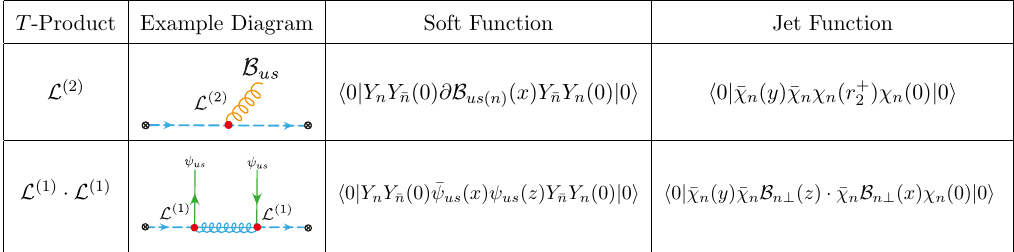
( (cid:21) 2 ) thrust cross section from radiative functions. O (2) insertions, in accord with the LBK theorem, L (1) insertions. We do not explicitly write the L